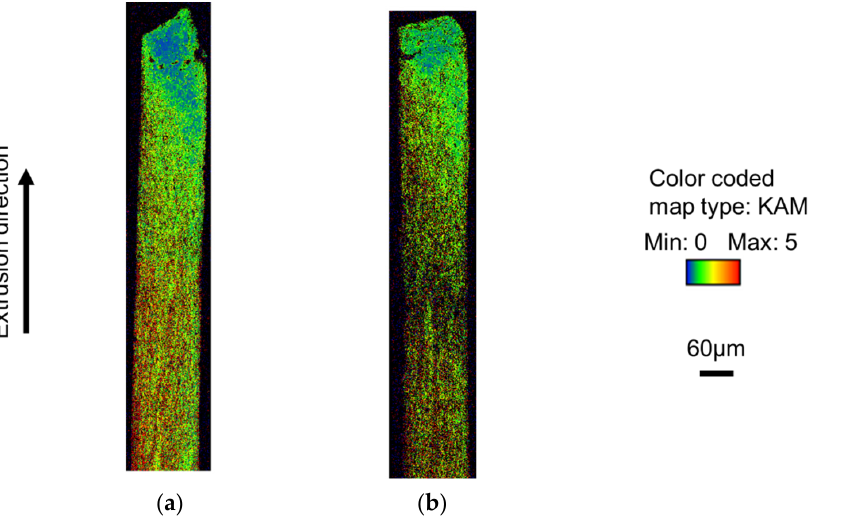
Figure 9. KAM map of the extrusion by EBSD: ( a ) mirror surface punch; and ( b ) grooved punch (depth 5 µm).